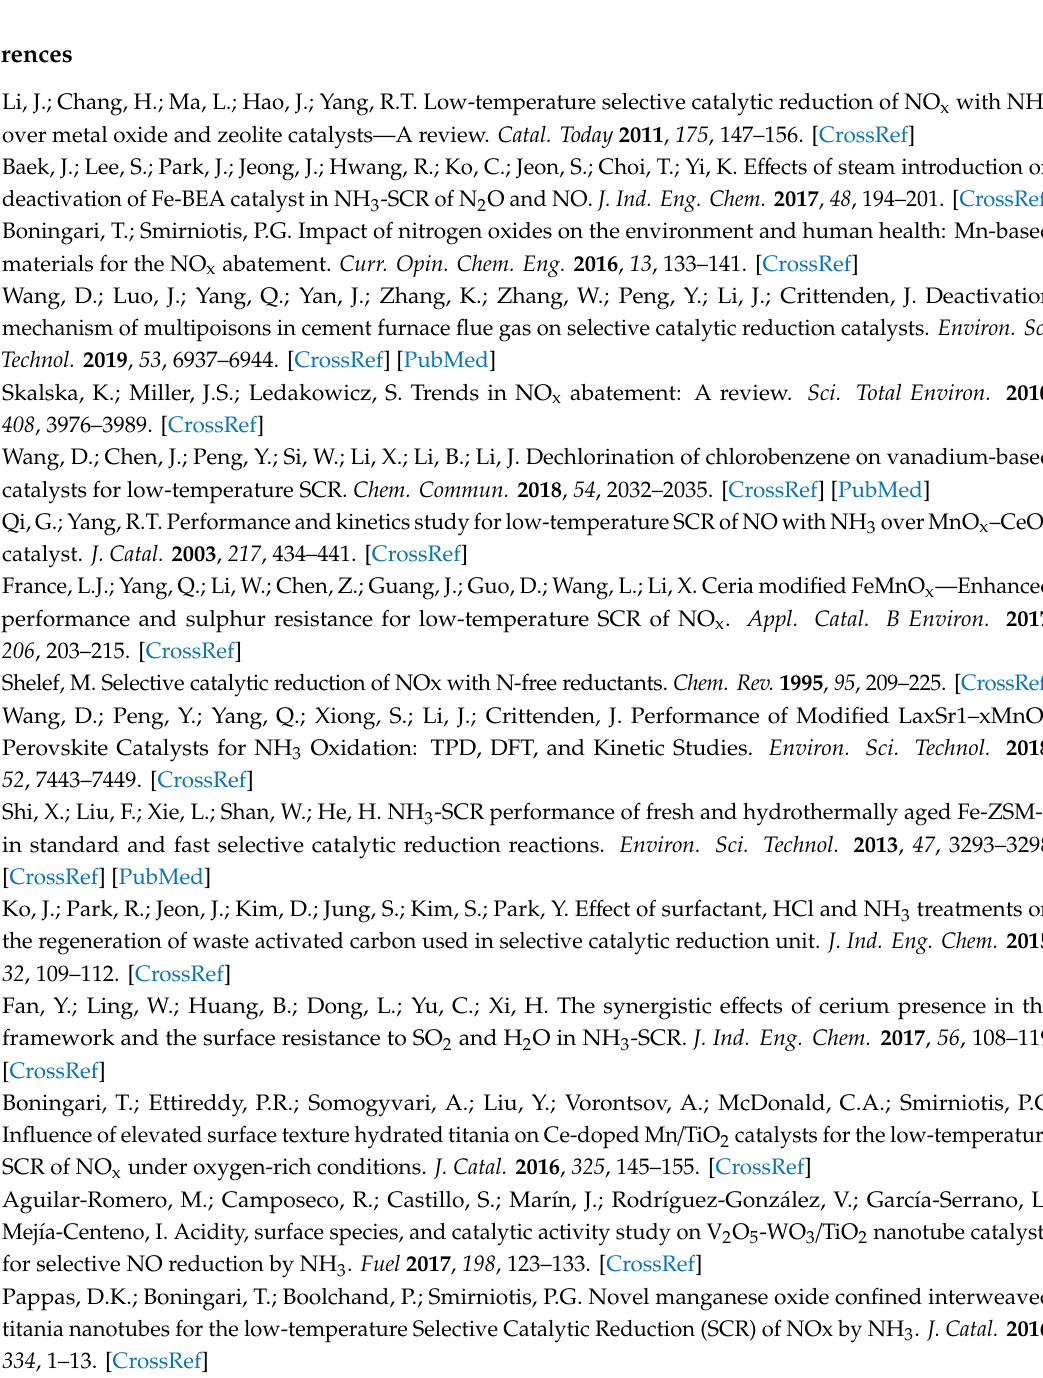
Figure S1: Powder XRD patterns of Fe 2 O 3